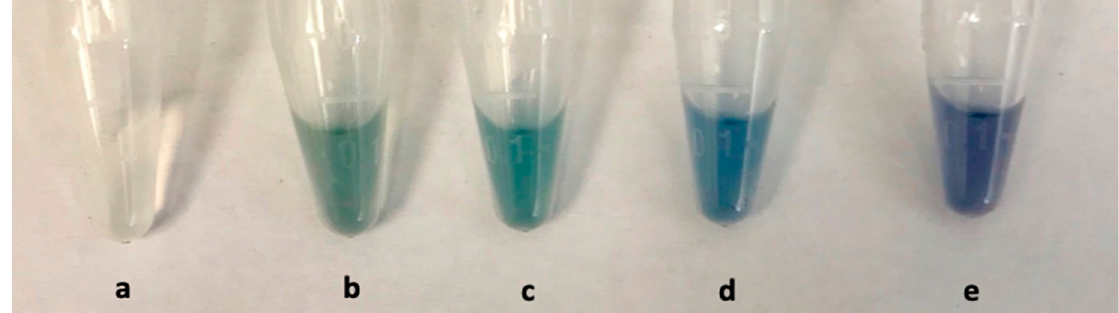
Figure 3. Feasibility of glucose detection in serum using AuNSs as detectors: ( a ) Blank serum; ( b ) control sample containing AuNSs in serum; ( c ) with 0 mmol/L glucose and detection solution (a mixture of AgNO 3 and NH 3 ); ( d ) 0.001 mmol/L glucose; and ( e ) 0.002 mmol/L glucose.